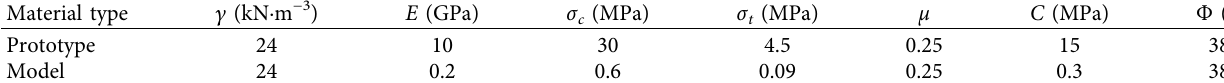
Table 1: Physical-mechanical parameters of rock and similar material.